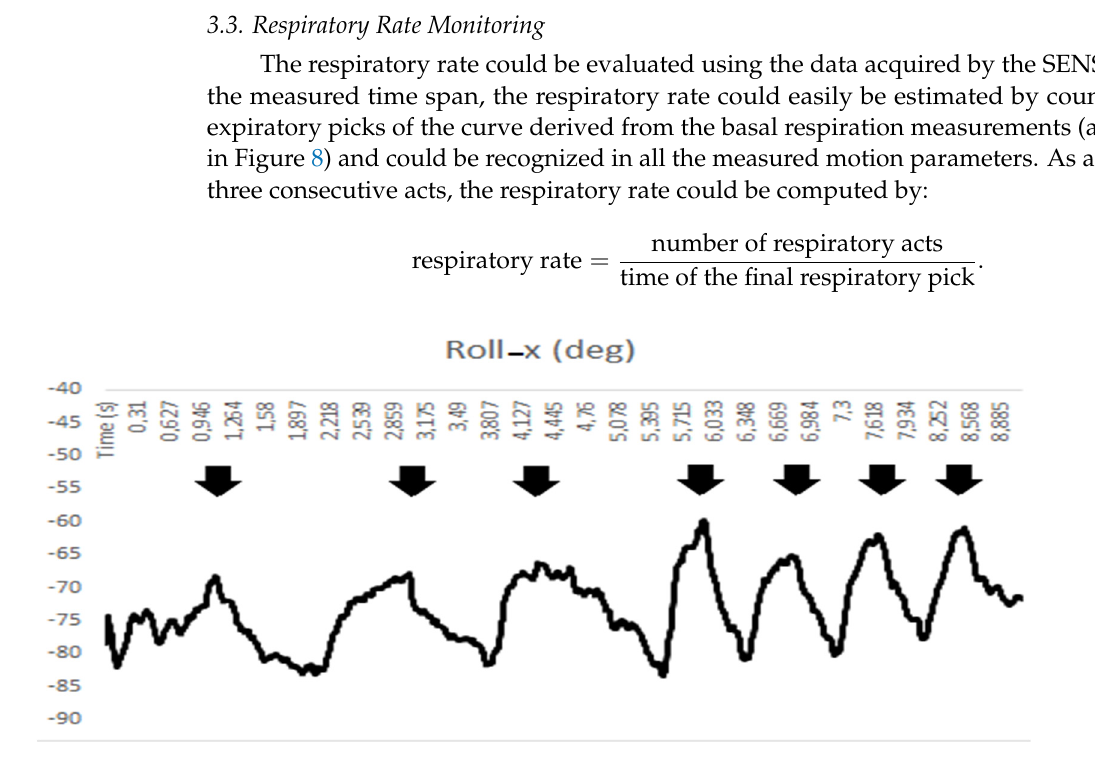
Figure 8. Acquired data by SENSIRIB used for computing the respiratory rate.